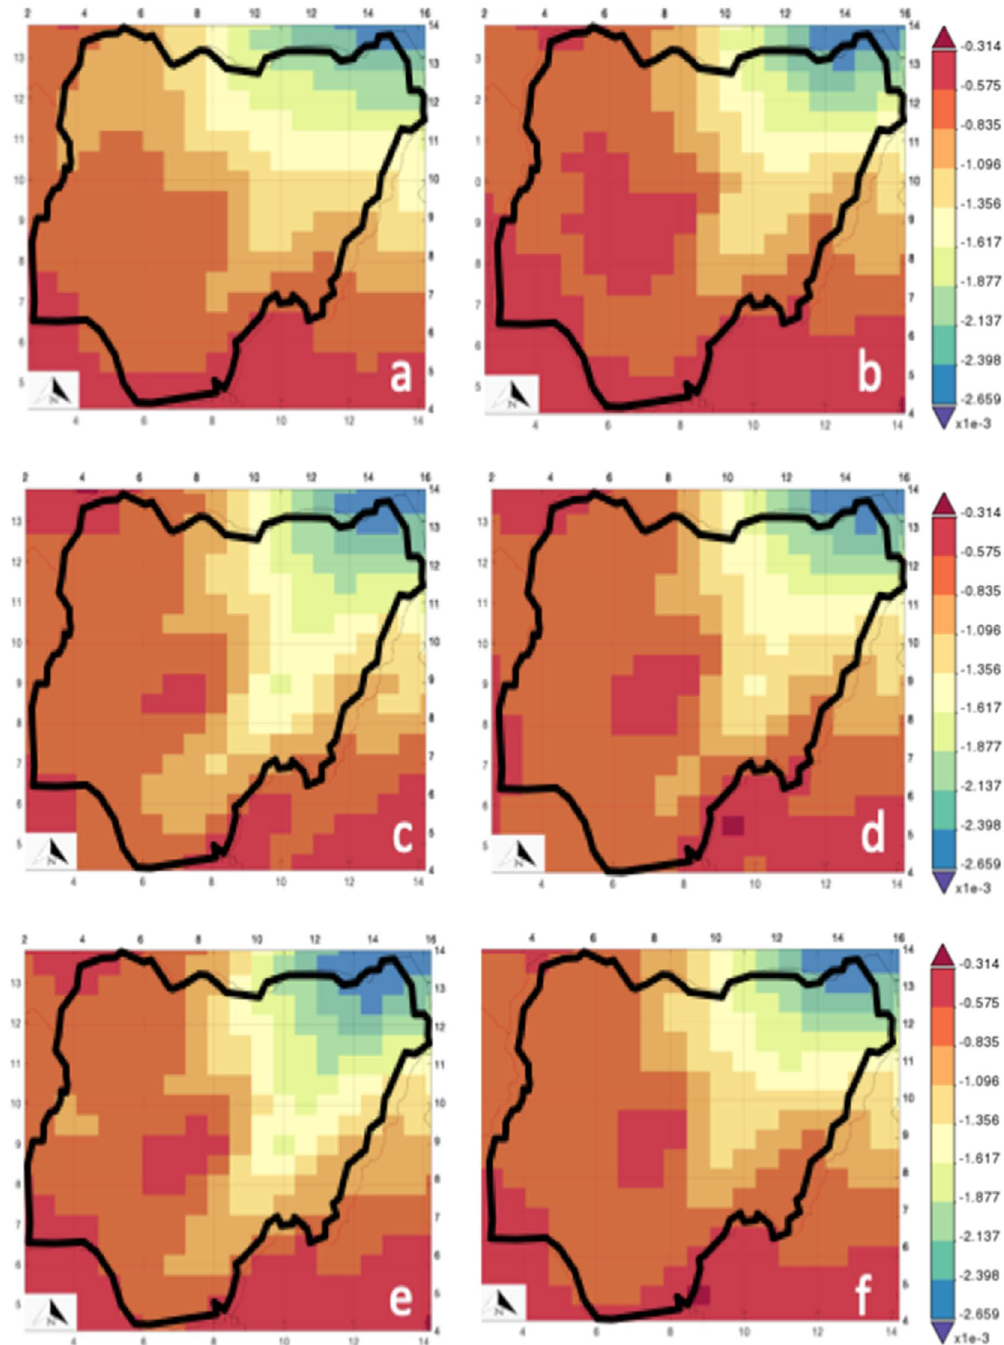
Figure 8. Dust column v-wind mass flux ( a ) 2010, ( b ) 2014, ( c ) 2015, ( d ) 2016, ( e ) 2017 ( f )